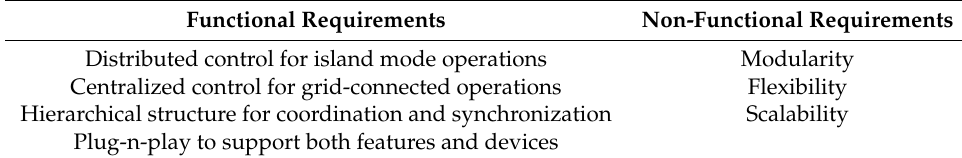
Table 1. Functional and non-functional requirements for microgrids according to the surveys and standards for microgrid controllers.